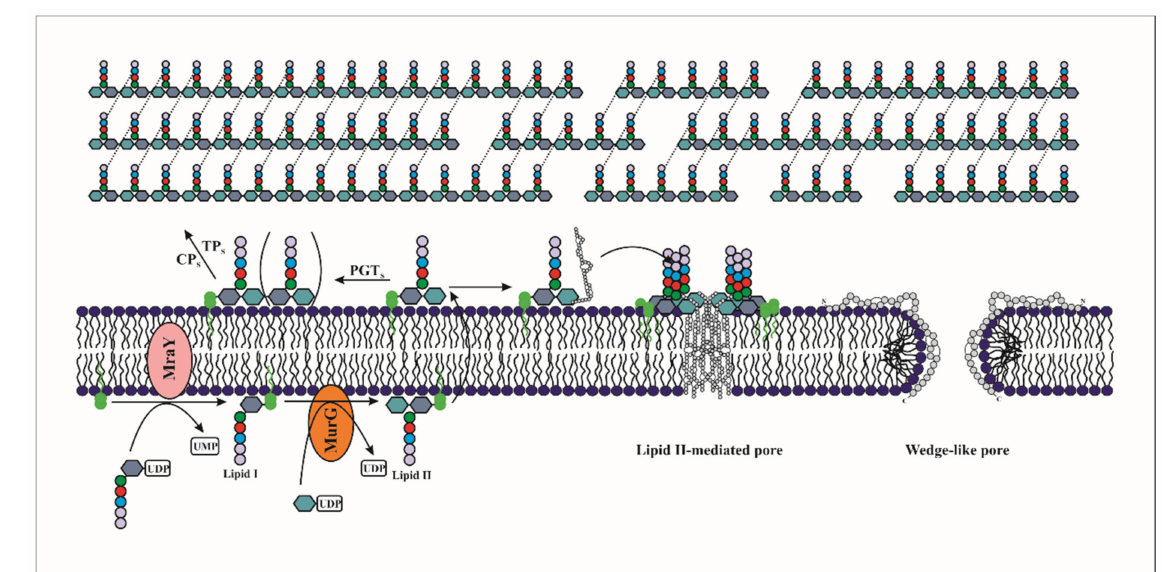
Figure 3. Scheme showing the mechanism of action for lantibiotic bacteriocins, mainly forming a pore into the target membrane by electrostatic interaction (wedge-like pores) or by binding to lipid II. Lipid II is formed in two steps: (i) the UDP-N-acetylmuramyl-pentapeptide is linked to the undecaprenyl phosphate by the enzyme MraY to obtain the lipid I; (ii) then, a unit of N-acetylglucosamine is linked to the N -acetylmuramyl by the enzyme MurG to obtain the final lipid II. After its formation, the lipid II is translocated across the membrane to the outer side, and oligomerized to form the cell wall. The cationic type-A lantibiotics (like nisin, depicted in the figure) can form a target-mediated pore using lipid II as a docking molecule. In addition, the hijacking of lipid II molecules for the formation of pores in the membrane can destabilise the formation of the wall, thereby weakening